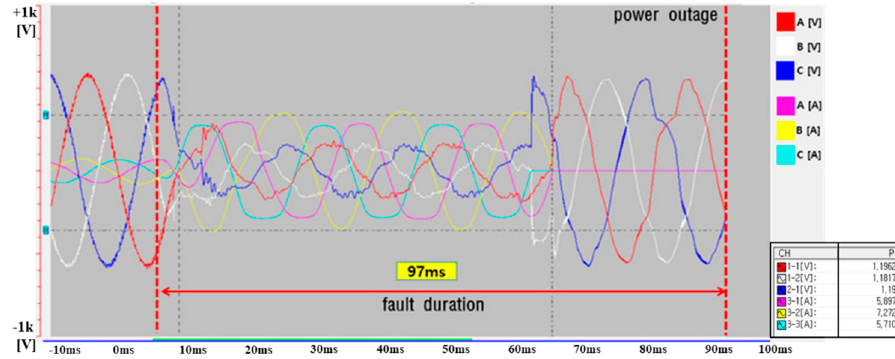
Figure 2. Characteristics of voltage and current on the ASS.